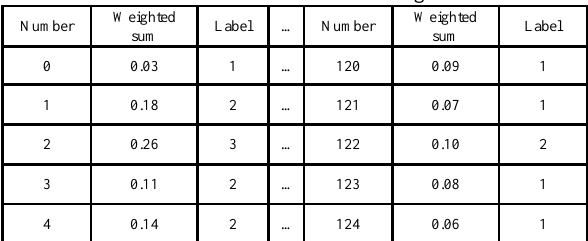
Table 5. Labels of influence